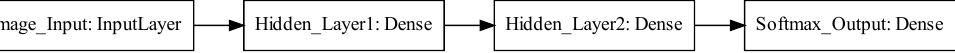
Figure 1. The simple ANN structure we used for the MNIST handwritten digit classification task. The second hidden layer is added to embed the learned features into 2D.